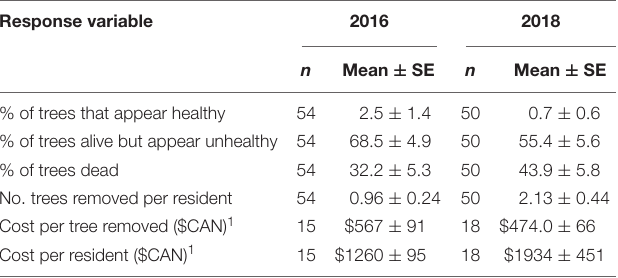
( Table 4 ). The percentage of American beech that were dead or had already been removed in 2016 was greater in Graham’s